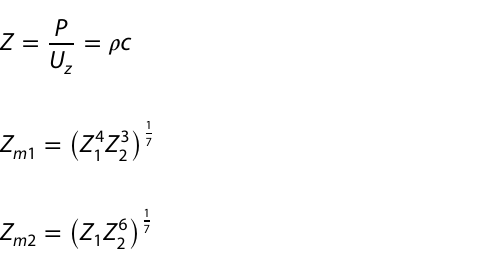
Table 2 Backing and matching material properties